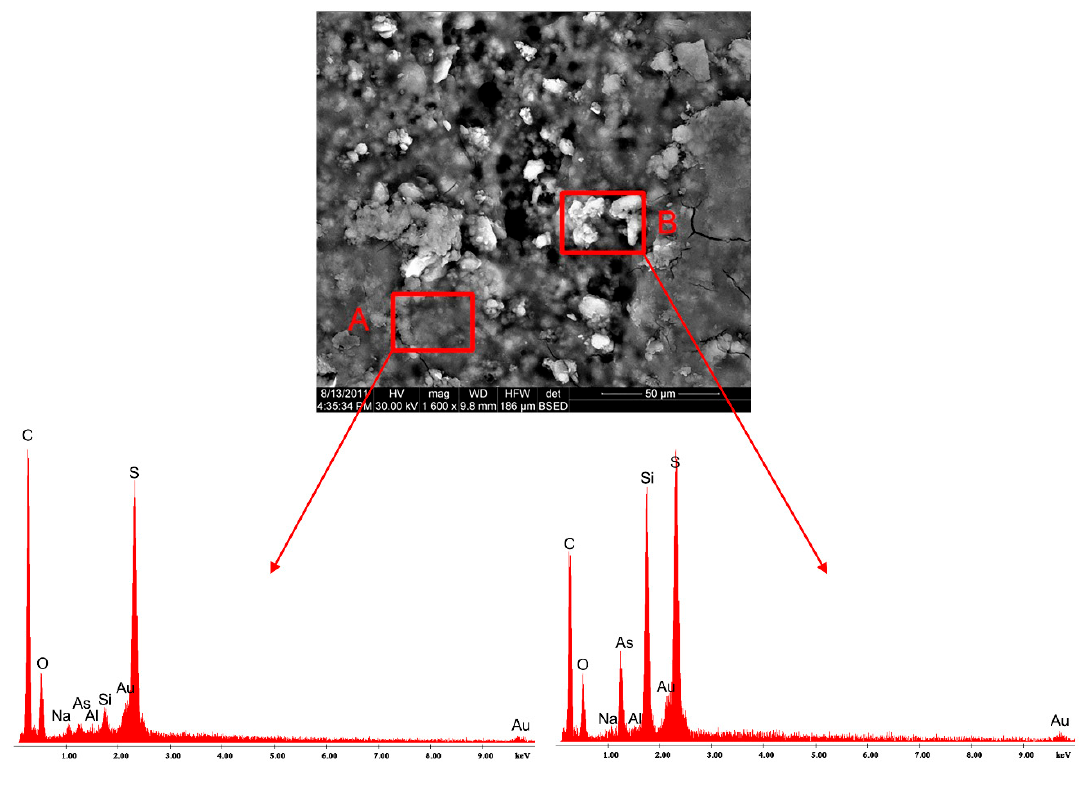
Figure 4. Energy dispersive X-ray analyzer (EDAX) analysis of the MXU pellet surface.